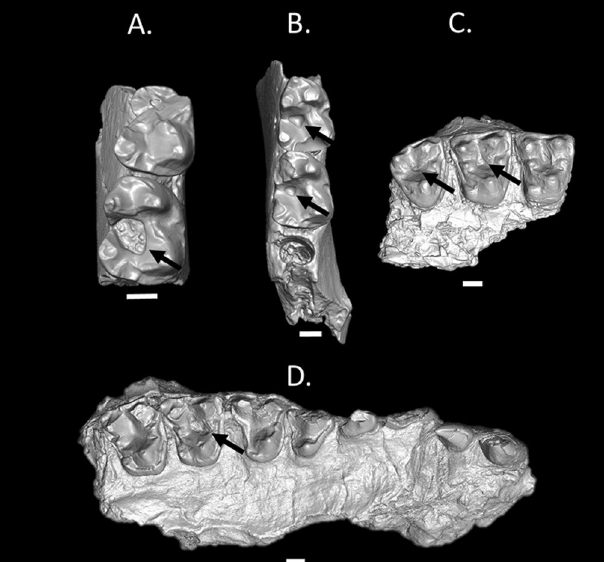
Figure 4. Micro-CT reconstructions of ( A ) a lower right jaw fragment (M 1 –M 2 ) (USGS 3787), ( B ) a lower right jaw fragment (M 1 –M 2 ) (USNM 537939), ( C ) an upper right jaw (M 1 –M 3 ) (USGS 1109), and ( D ) an upper right jaw (I 1 –M 2 ) (USGS 9194). Note that in each tooth, the caries is primary and located in the occlusal basin. Black arrows denote the carious lesions. Scale bar = 1 mm. Buccal is towards the right in the lower teeth and towards the top in the upper